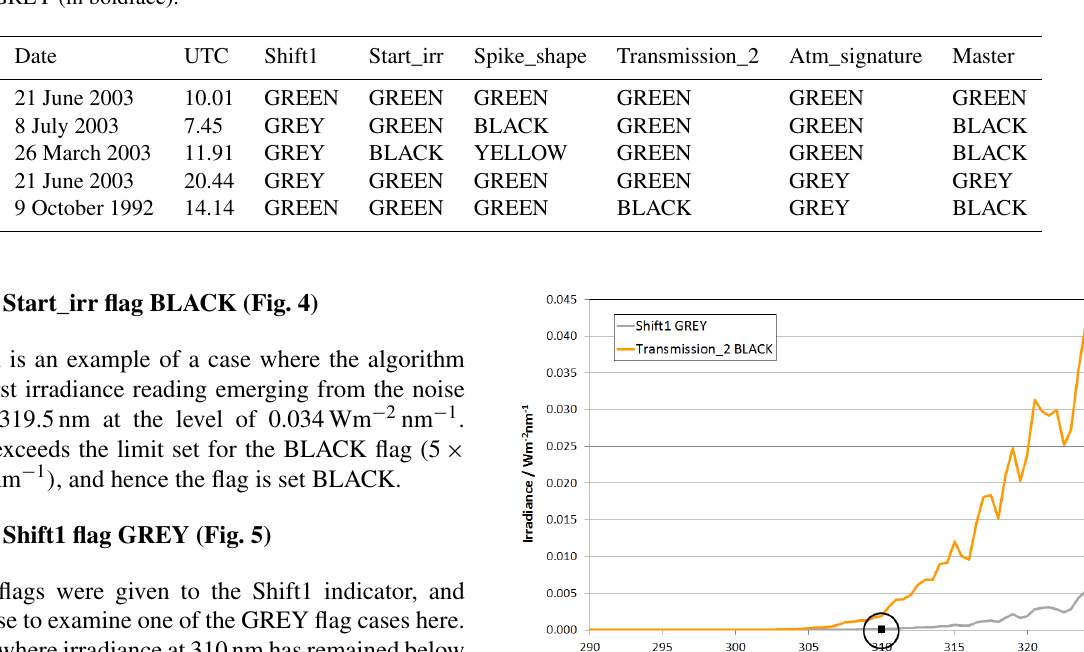
Table 6. Cases of UV irradiance spectra retrieved from the EUVDB as representatives for different flag colours of the various quality indicators. Case 1 used as a reference with all flags GREEN; cases 2–5 representing spectra for which a particular quality indicator flagged as BLACK or GREY (in boldface).